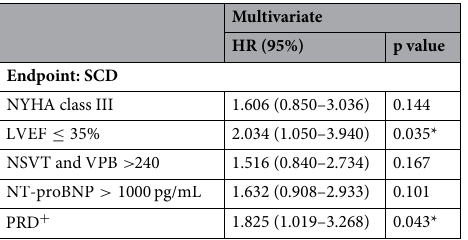
Table 4. Multivariate SCD risk prediction including the following variables: NYHA class, LVEF ≤ 35% , combined NSVT and VPB > 240 , NT-proBNP > 1000pg/mL and PRD + . ∗ p < 0.05 .